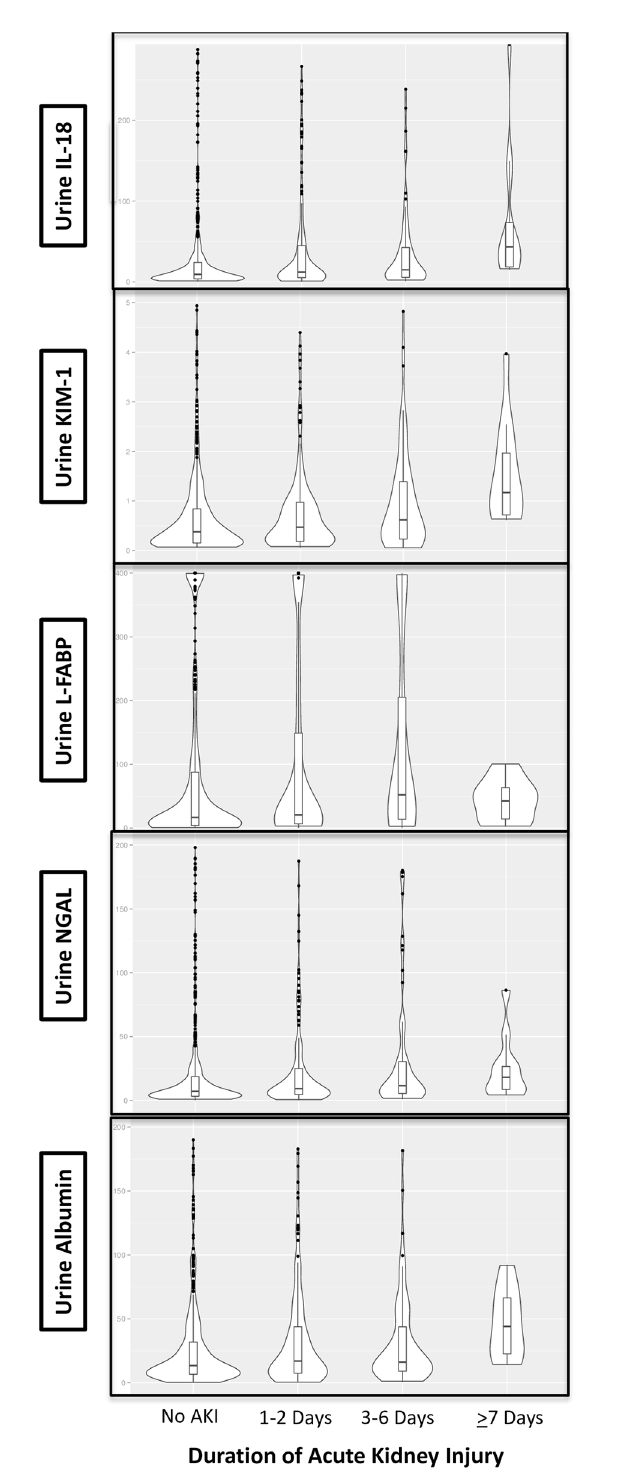
Fig 1. Violin Plots for Biomarker Levels With Acute Kidney Injury Duration. These violin plots demonstrate that patients with shorter duration of AKI tended to have a more skewed distribution of all 5 biomarkers, with their biomarker values skewed towards low